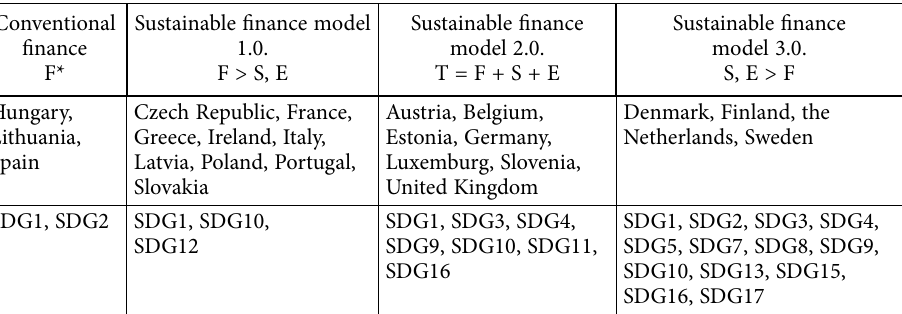
Sustainable finance model